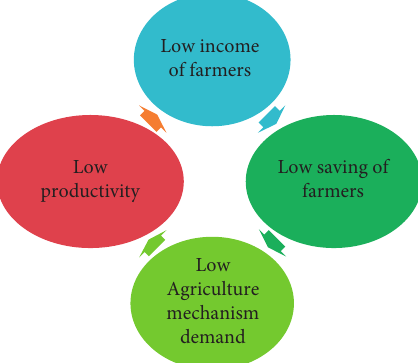
Figure 1: Various cycles of agriculture mechanisms under